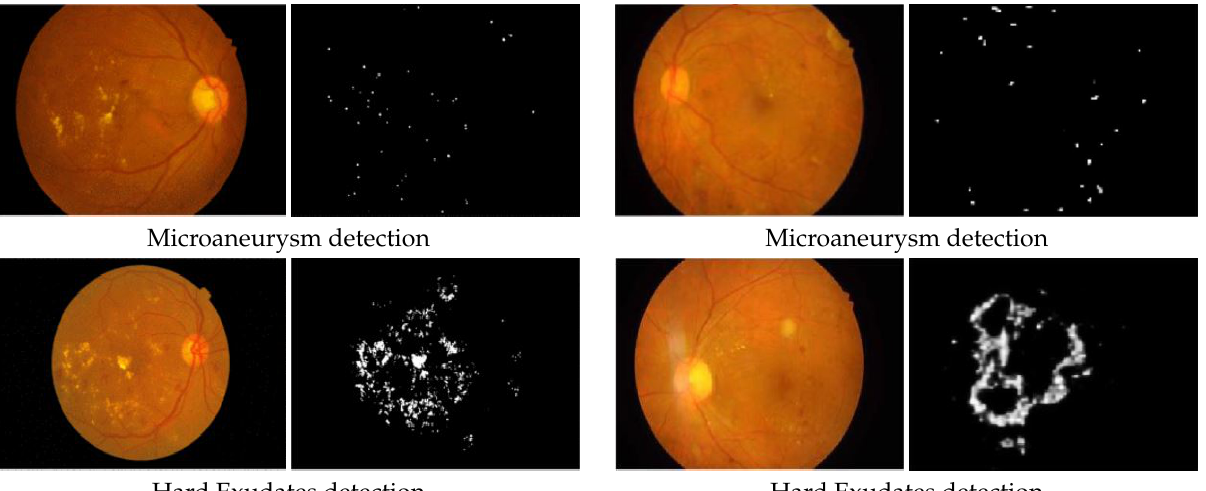
Figure 5. comparison of deep-learning-based diabetic retinopathy microaneurysm detection and hard exudates detection results performed by [35,43] respectively on the IDRiD